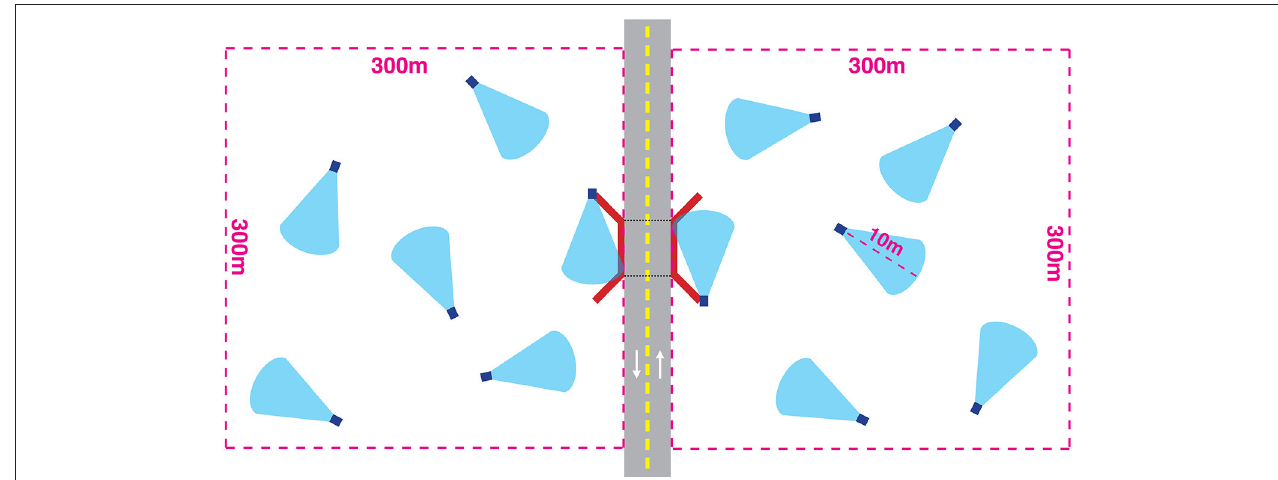
FIGURE 2 | Camera placements in relation to a wildlife highway crossing structure (not to scale). Twelve HyperFire PC900 Reconyx TM trail cameras (dark blue squares indicate cameras, light blue cone indicates approximate 40 ◦ sampling window) were installed at each site for ∼ 2 weeks at each site. Ten cameras were installed at randomly generated points at least 50m apart within a 300m by 300m area adjacent to each side of the structure (red lines represent concrete retaining walls associated with all crossing structures). Two cameras were installed at each entrance to the structure. Cameras were installed ∼ 3m from the ground and a stake was placed to demarcate a 10m viewing distance commensurate with the viewing distance of the cameras at the structure